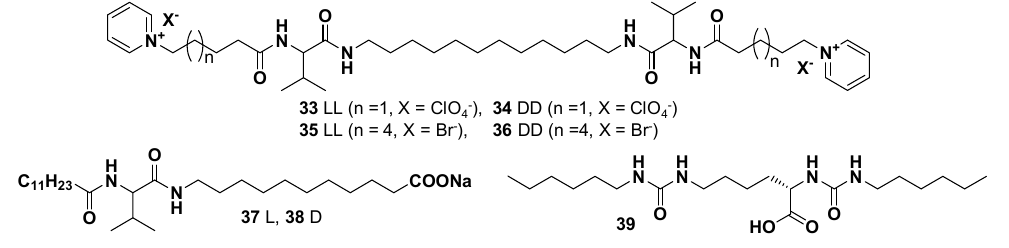
Chart 5. Amphiphiles used for templating inorganic superstructures.